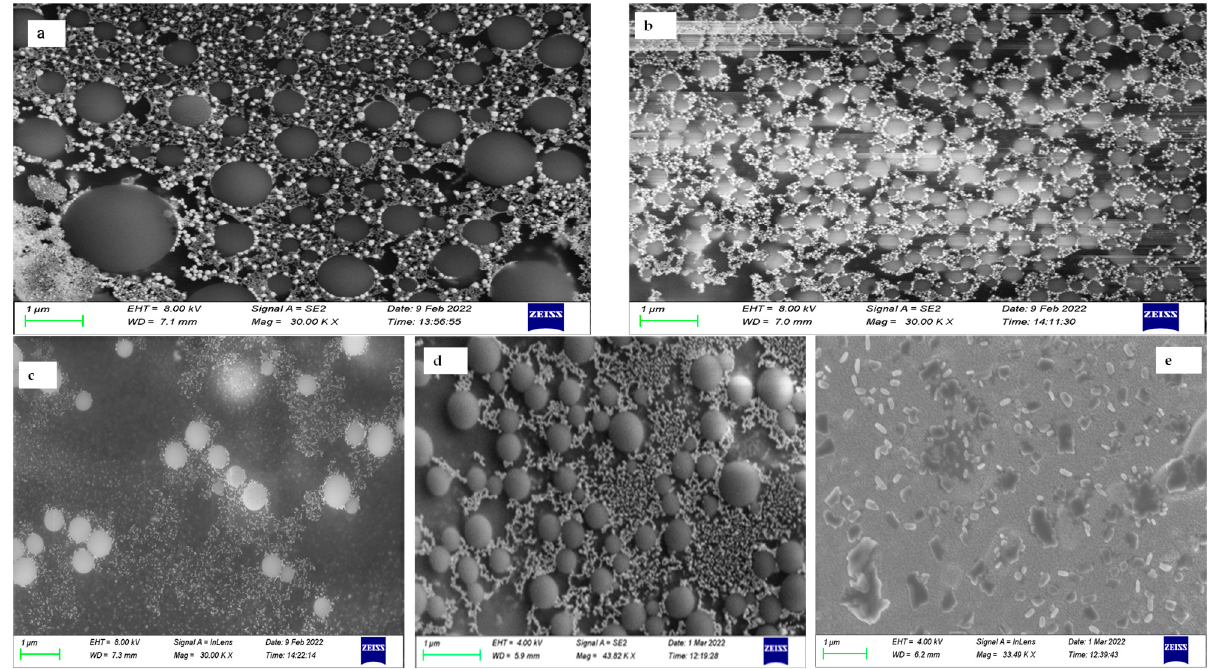
Figure 3. SEM images of transferosomes reflecting the impact of drug loading on the polydispersity and size for. ( a ) blank Span ® transferosomes; ( b ) CysA-loaded Span ® transferosomes; ( c ) blank Tween ® transferosomes; ( d ) CysA-loaded Tween ® transferosomes; and ( e ) lyophilized Tween ® transferosomes. Scale bar represents 1 µm.